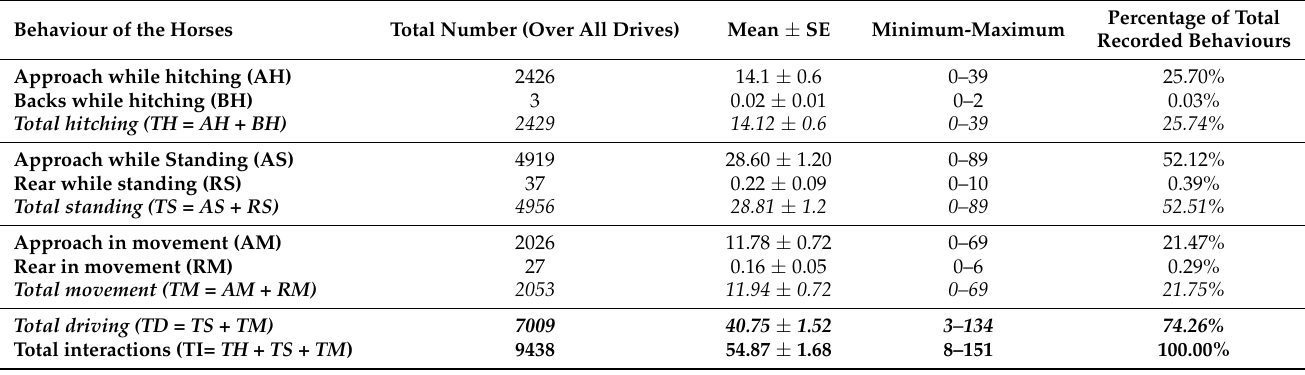
Table 4. Descriptive statistics of the number of observed horse interactions between stallions driven in pairs highlighted in bold over the course of the study (Total number of occurrences; mean ± SE; min-max; percentage of total recorded behaviours). The behaviours in italics indicate the behaviours regrouped by type of behaviour. The number of occurrences in italics indicates the number of occurrences for the behaviours regrouped by type of behaviours. The number of occurrences in italics and bold indicates the number of occurrences for the total driving. The number of occurrences in bold indicates the number of occurrences for the total interactions. See Table 3 for the detailed ethogram.